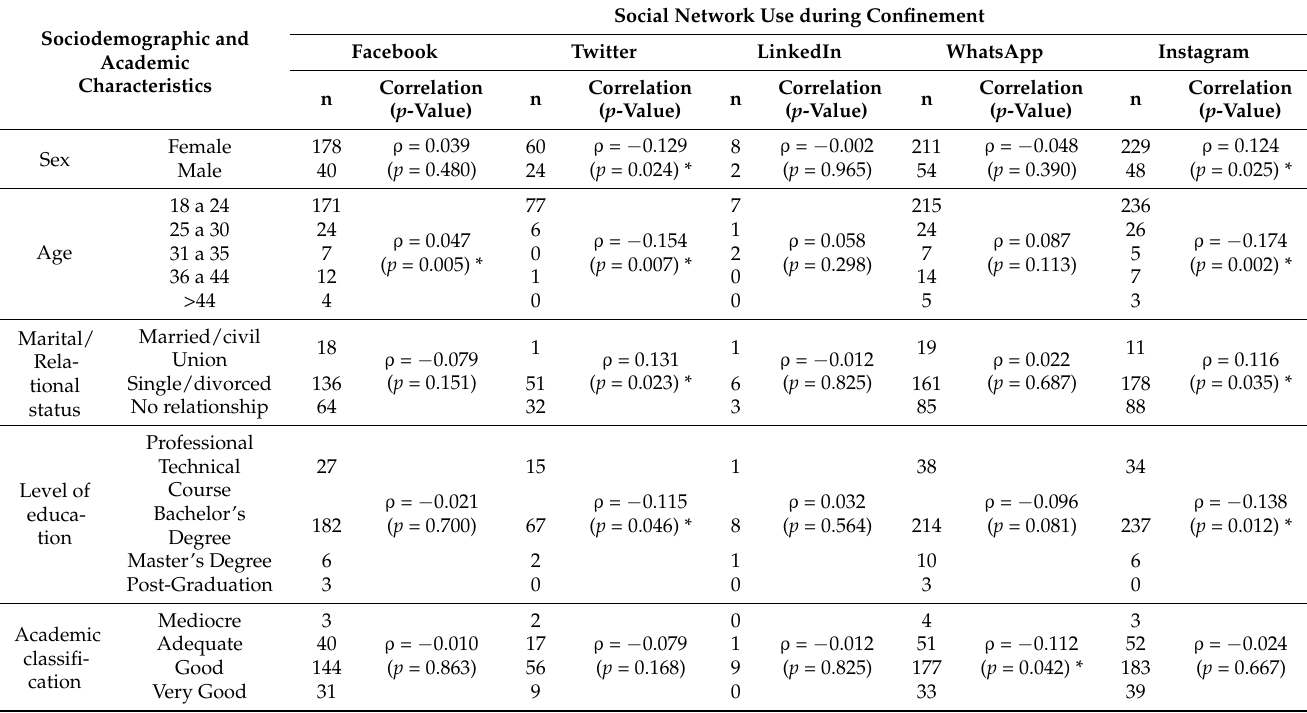
Table 6. Sociodemographic of the sample and the use during confinement, of social